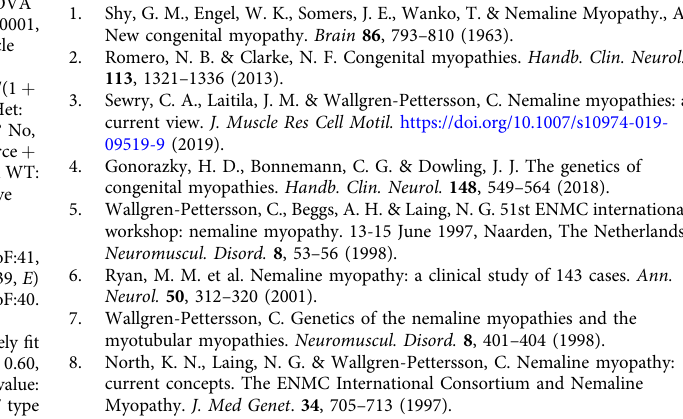
Figure 7a) Allosteric sigmoidal curve with as test: does one curve adequately fi t the data? No, P < 0.0001. F-value: 8.146, DoF: 363. Goodness of fi t: R 2 in WT: 0.60, in Compound-Het: 0.44. b – g) Unpaired two-tailed T-tests. b) P = 0.0464, T-value: 2.035 and DoF: 58, d) P = 0.0282, T-value: 2.246 and DoF: 58, On average, 7 type